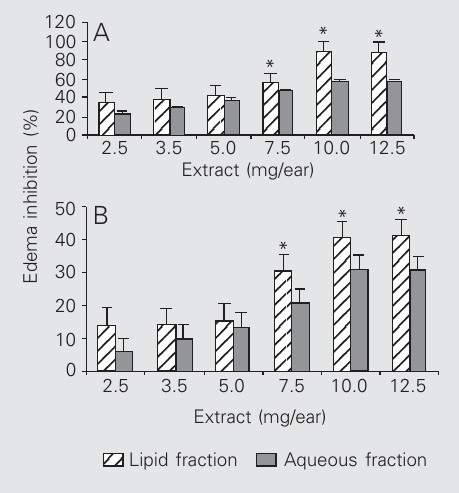
Table 1. Inhibitory action of the lipid and aqueous fractions of Ipomoea imperati leaf extract on phos- pholipase A 2 activity. Extract Concentration